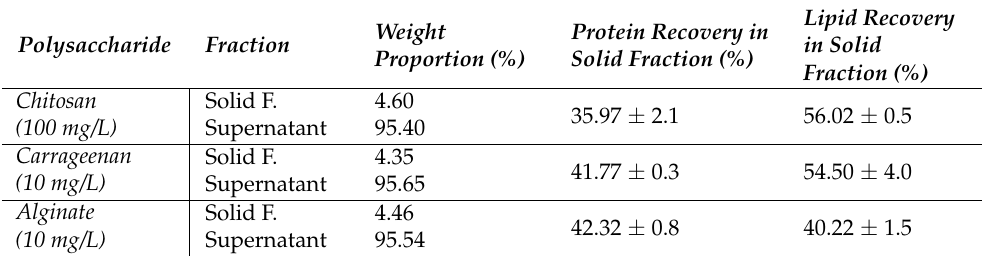
Table 3. Protein and lipid recovery obtained by the use of Coagulant or Flocculant applied individu- ally. Analytical data are shown as mean ± SD (n = 3).